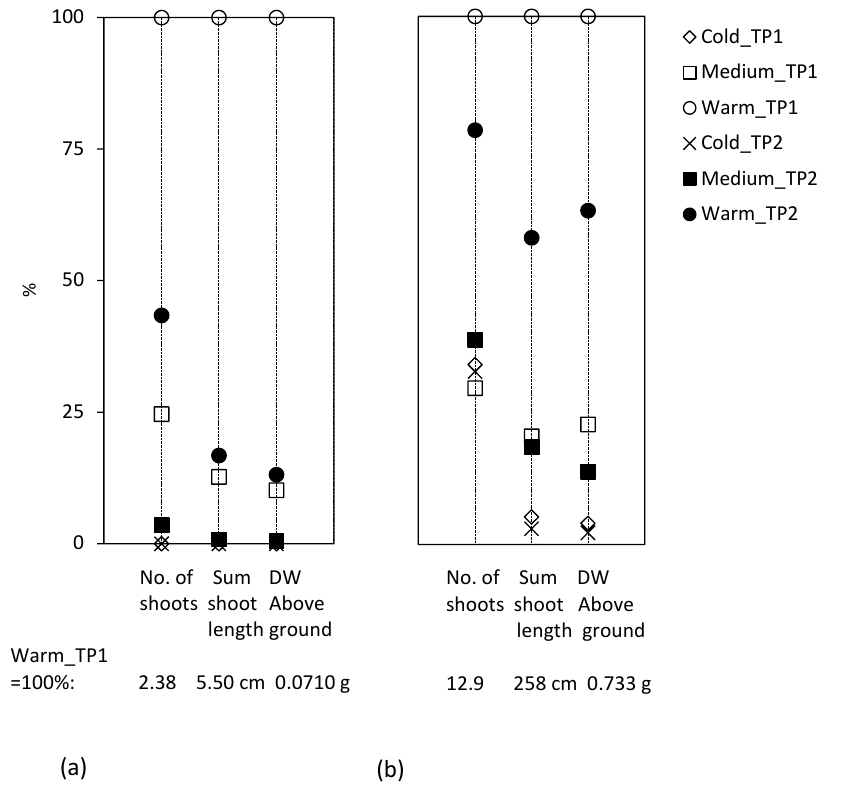
Figure 2. Effect of the temperature in the growth chambers (see text) on ( a ) C. arvense and ( b ) E. repens in two test periods (TP); the mother plants resulted from the experiment Climate Change. The values are expressed as percentages at the warm temperature for the test period 1 (Warm_TP1).